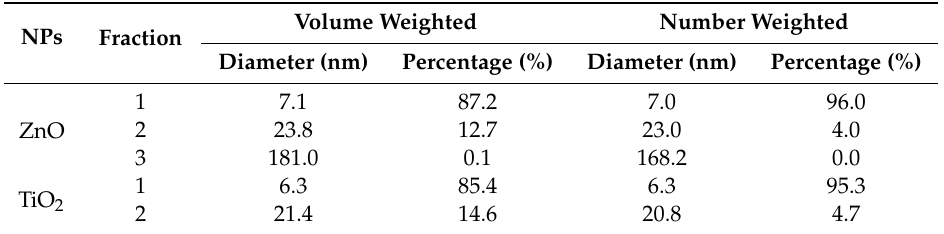
Table 1. Size and particle size distribution of ZnO and TiO 2 NPs in commercial dispersions as obtained by the DLS analysis.